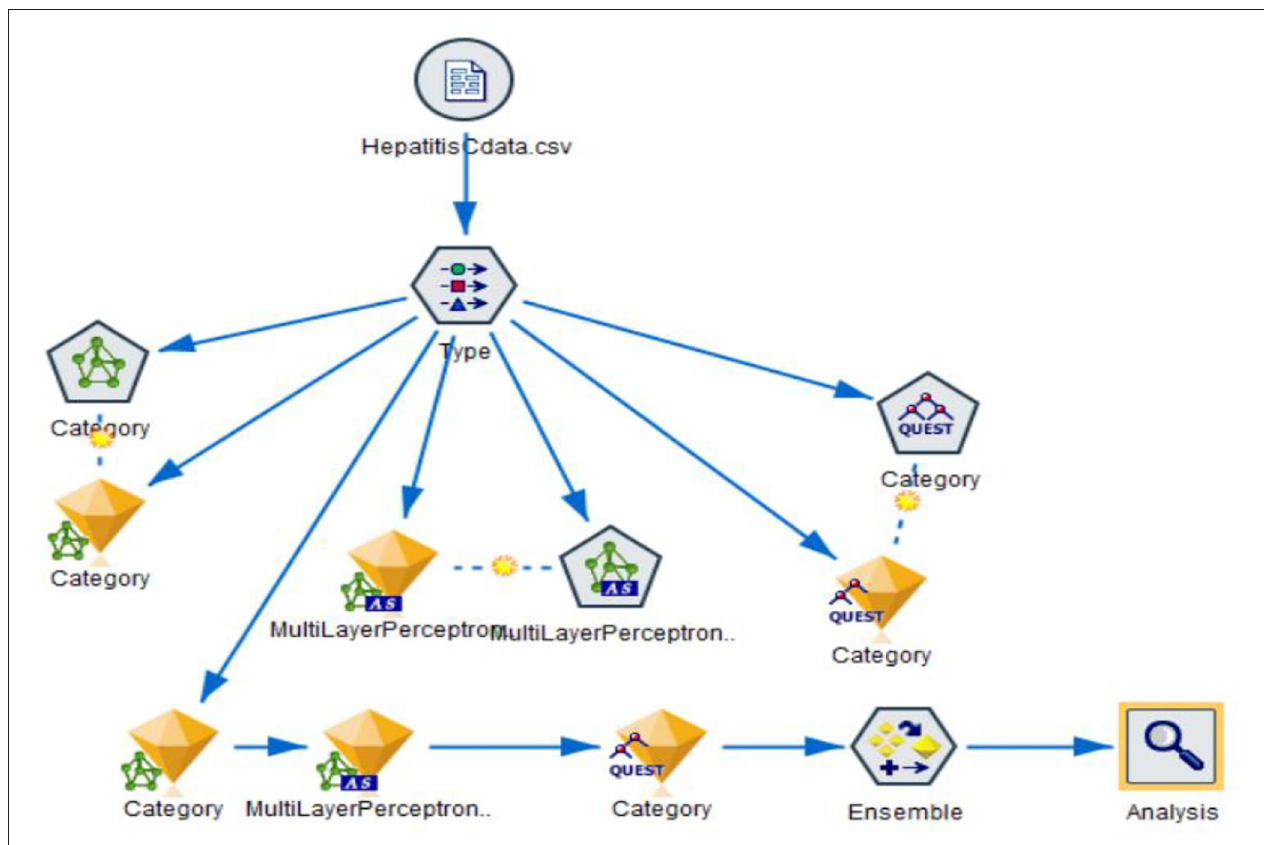
FIGURE 9 | Proposed Ensemble learning